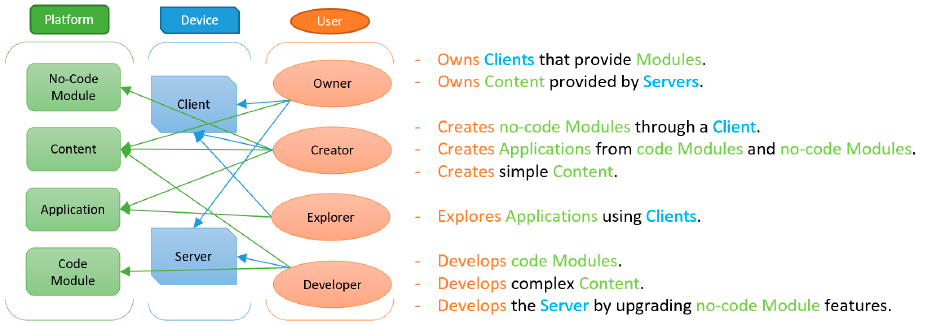
Figure 2. The roles of a user in relationship with the platform’s components and the devices that contribute to the distributed ecosystem.